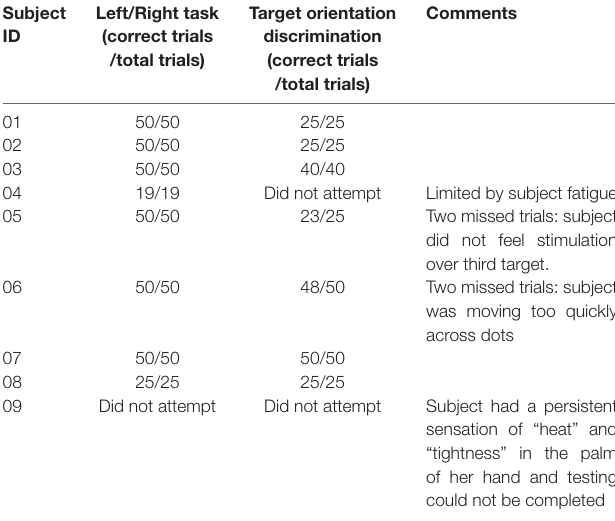
TABLE 4 | Target localization and discrimination tasks